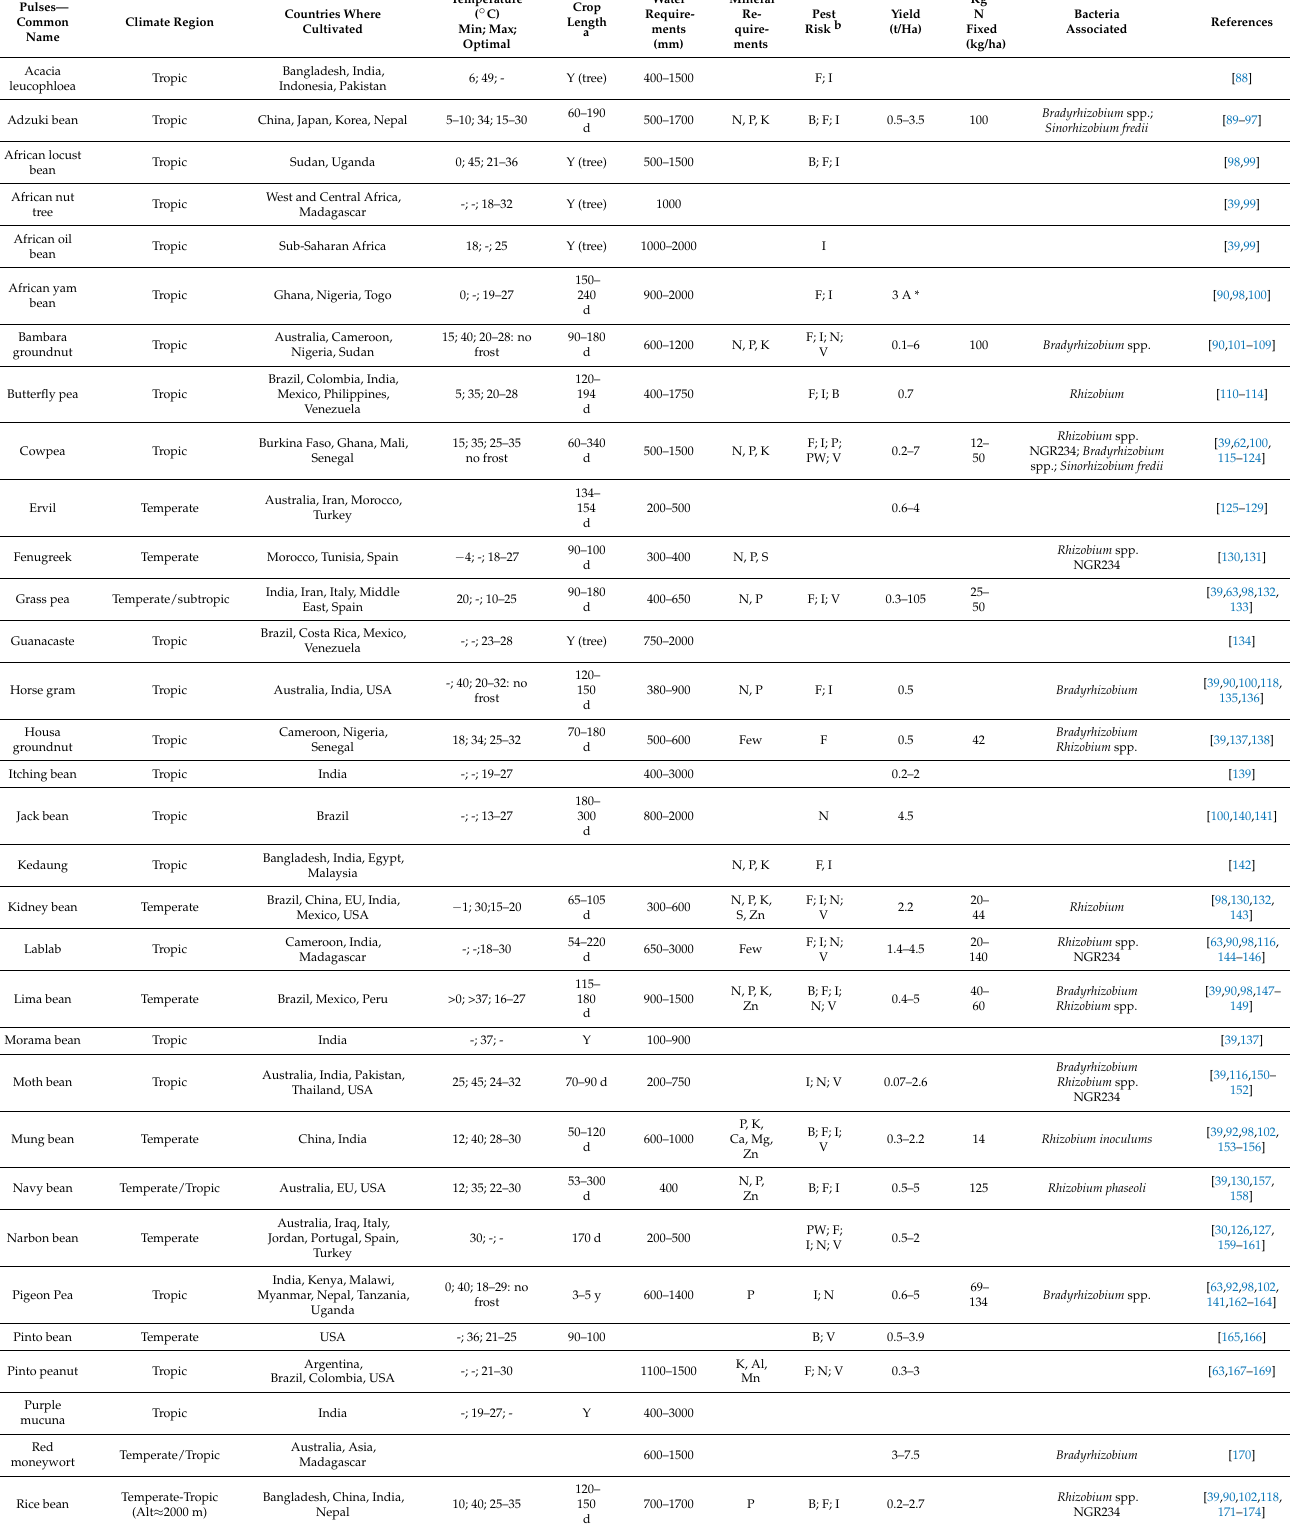
Table A1. Agronomic requirements of minor and major pulses in grey major